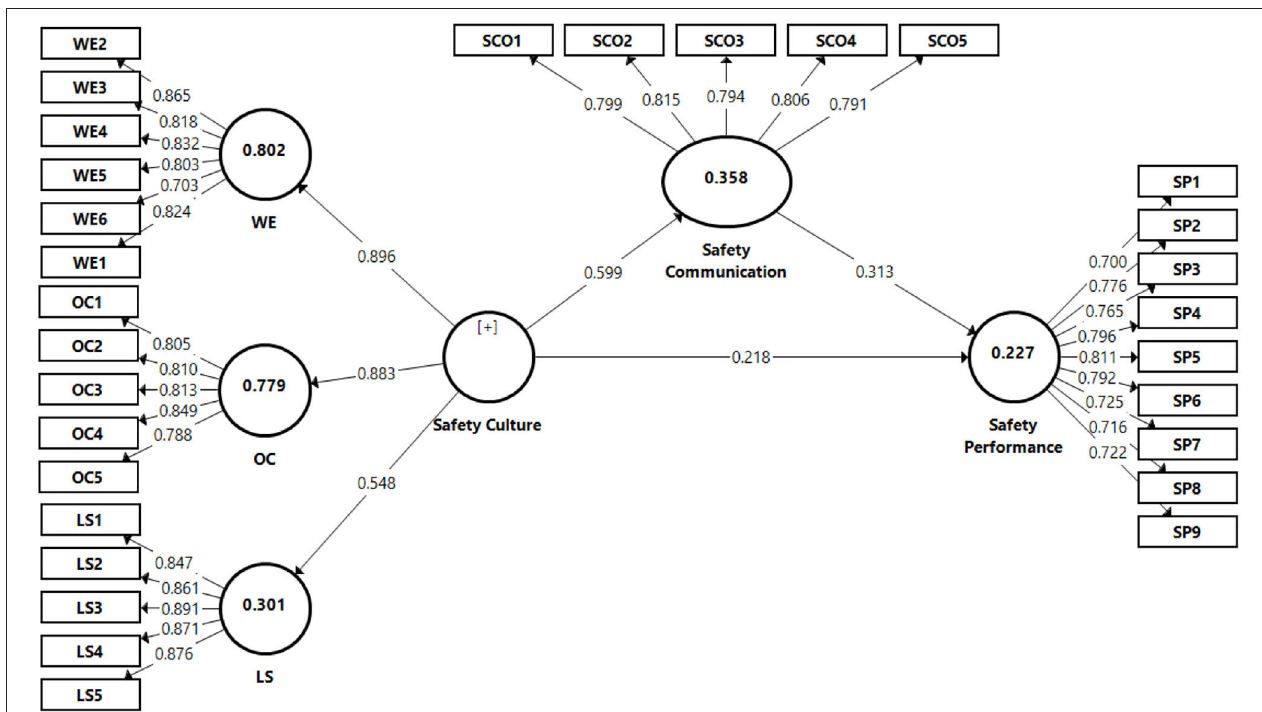
FIGURE 3 | Final structural model (PLS results).